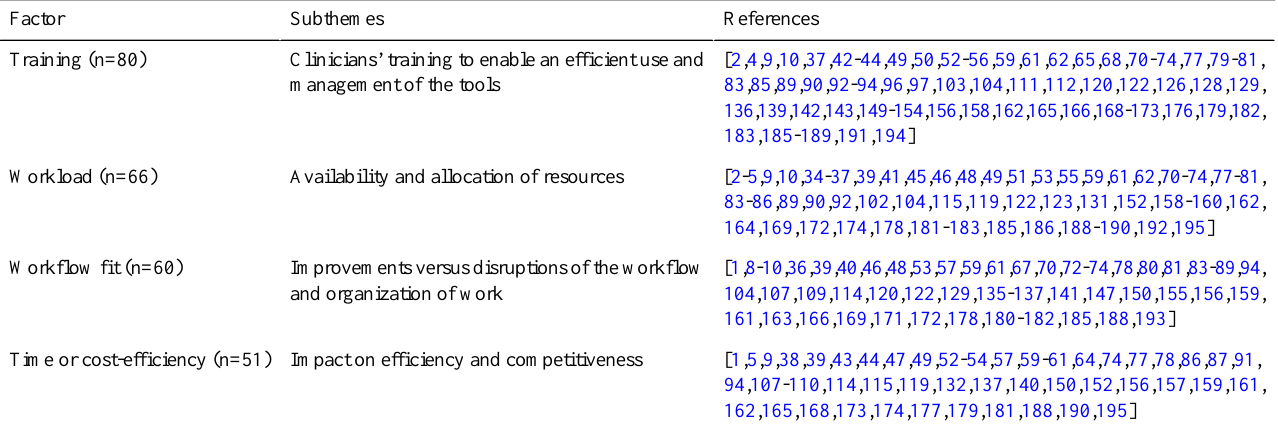
Table 3. Workflow-related factors and their occurrence, with